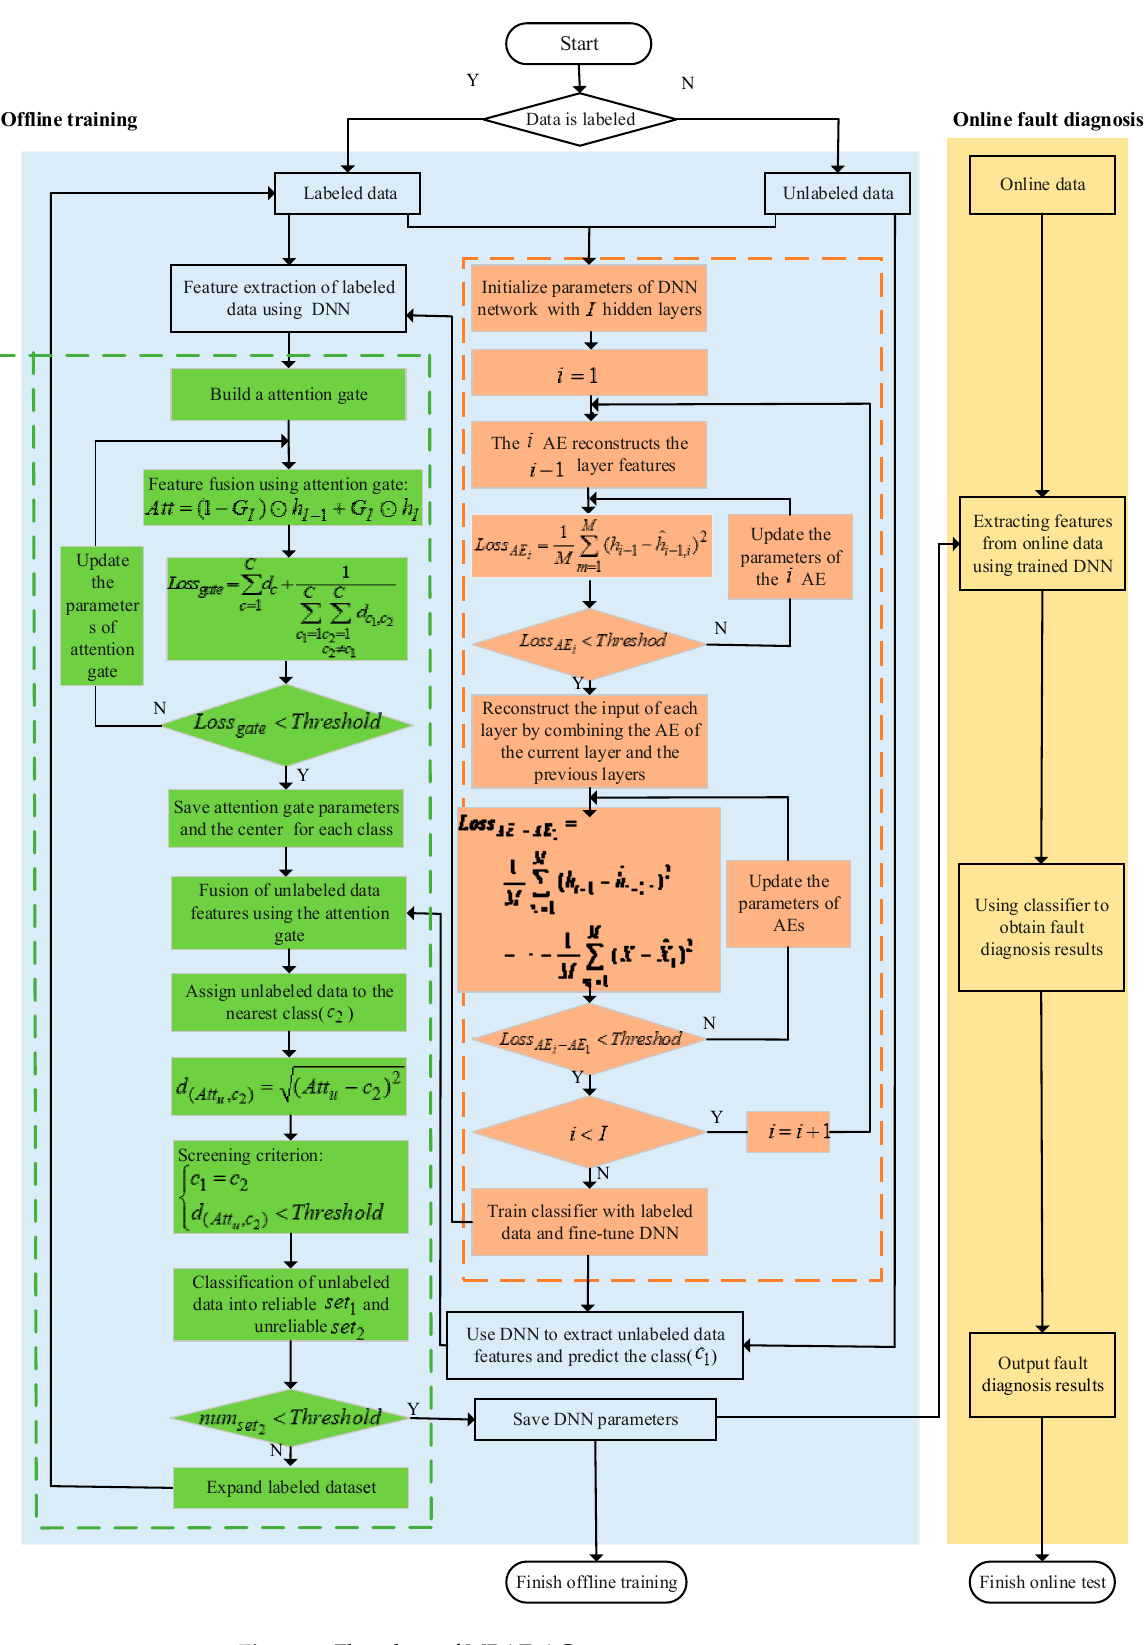
Figure 4. Flowchart of